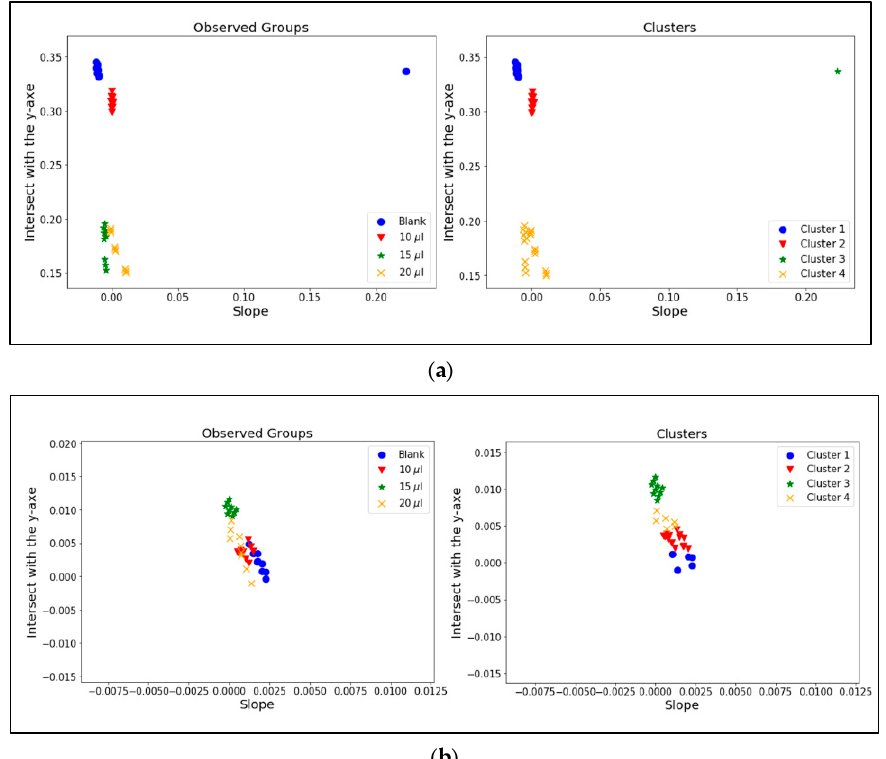
Figure 4. Cluster correlations of Mn ( a ) and Pb ( b ) results for nails samples.